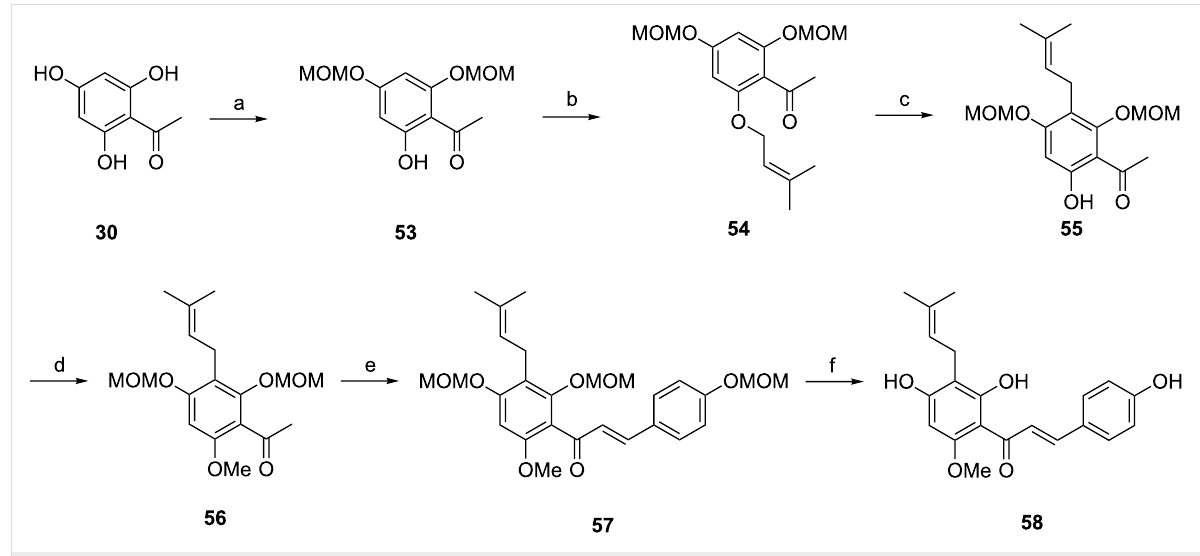
Scheme 9: Synthesis of xanthohumol 58 . Reagents and conditions: (a) MOMCl, diisopropylethylamine, CH 2 Cl 2 ; (b) 3-methyl-2-butene-1-ol, diethyl azodicarboxylate, PPh 3 , toluene/THF; (c) N , N -dimethylaniline, reflux; (d) (CH 3 O)SO 2 , K 2 CO 3 , acetone, reflux; (e) 4-methoxymethylbenzaldehyde, aqueous NaOH, MeOH, reflux; (f) concentrated HCl (pH 1), MeOH/H 2 O,